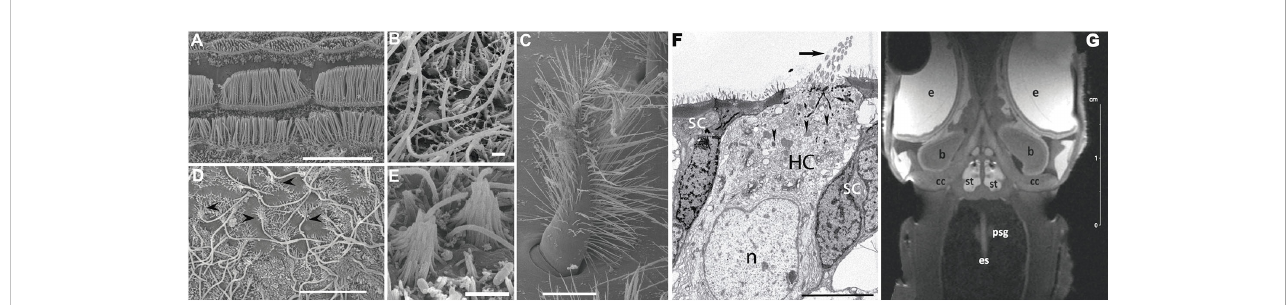
FIGURE 1 Imaging Techniques. (A – E) : Scanning Electron Microscopy. (F) : Transmission Electron Microscopy. (G) : Magnetic Resonance Imaging. (A – F) : Different types of sensory epithelia (hair cells) depending on the marine invertebrate group ( A, F : Cephalopods. (B, E) : Cnidarians. C : Crustaceans. D : Gastropods). (A) : View of three rows of hair cells (bundle of kinocilia) in statocyst crista epithelium of Sepia of fi cinalis . (B) : Statocyst sensory epithelium of the jelly fi sh Cotylorhiza tuberculata. Hair cells carry an only nonmotile kinocilia surrounded by a short crown of stereocilia (Sole ́ et al., 2016). (C) : A seate (bearing hairs) of the medial group sensory epithelia in the hermit crab Dardanus calidus statocyst. Setae are typical hair cell on crustaceans. (D) : Apple snail ( Pomacea maculata) inner statocyst sensory epithelia. Arrowheads point to the hair cells exhibiting their lonely kinocilia surrounded by a crown